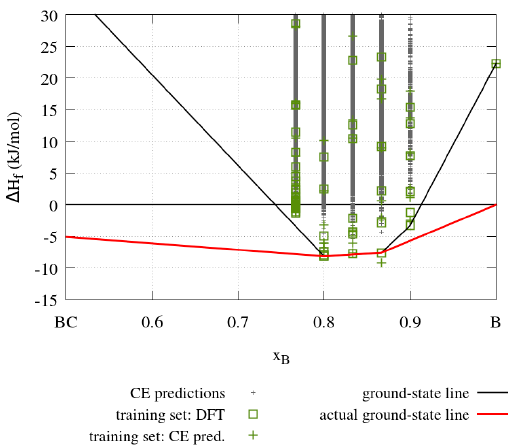
Figure 13. Enthalpy of formation ( ∆ H f ) as a function of the boron concentration x B of a binary cluster expansion of boron carbide. The solid black line indicates the convex hull with the pure phases based on the boron carbide crystal structure fully occupied by carbon and boron atoms, respectively. The solid red line shows the correct ground-state line connecting the graphite and α -boron. The green squares show the DFT enthalpies of formation of the structures in the training-set, green crosses the CE predicted enthalpies of formation of the training set structures and the grey crosses the CE predicted enthalpies of formation of all the other structures considered by the cluster expansion. Note that the true ground state line results throughout from DFT calculations. The green cross found below the ground state line at x B = 0.8667 corresponds to the green square found slightly above on the ground state line; the difference between both enthalpies may be taken as a measure of the accuracy of the CE